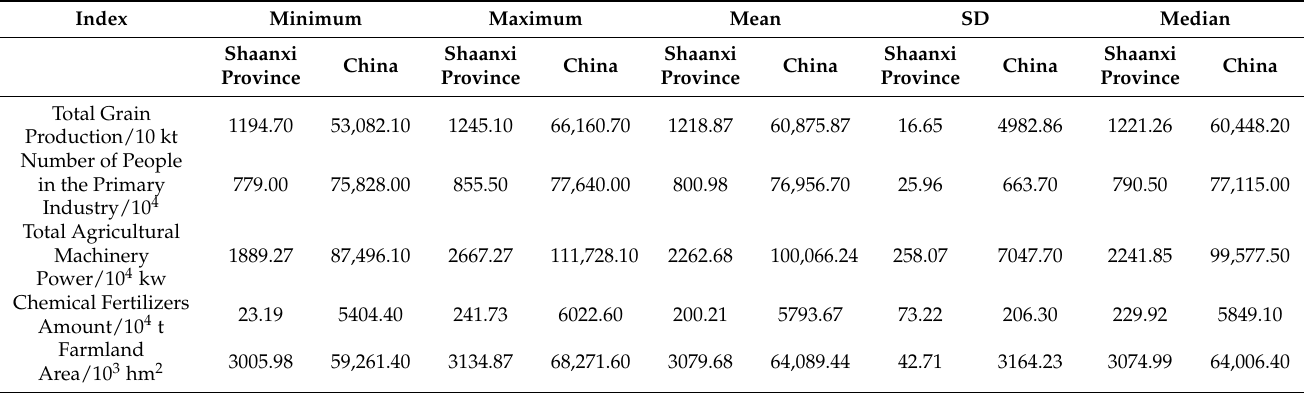
Table 1. Descriptive statistics of selected variables (Shaanxi Province and